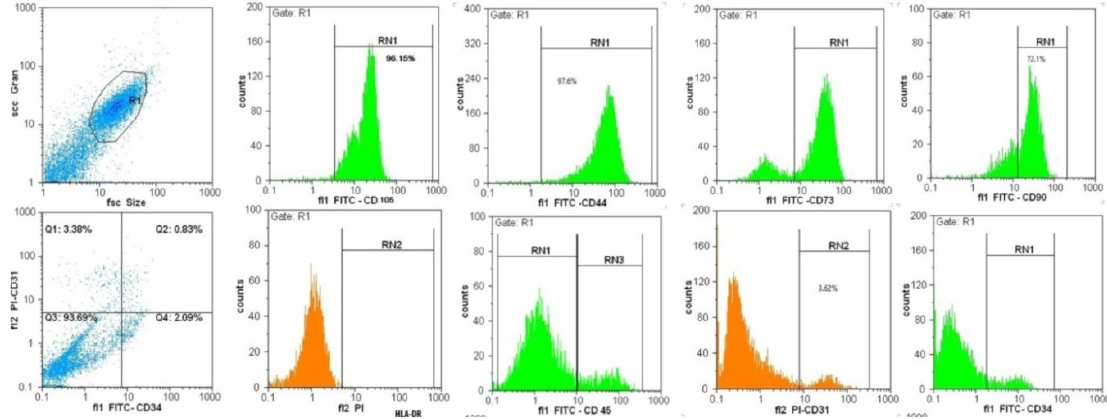
Figure1. Flow cytometry-based immunophenotyping of umbilical cord mesenchymal stem cells derived by MEEM. Cells are prominently positive for CD105, CD44, CD73, and CD90 and negative for HLADR, hematopoietic surface cell markers CD45, CD34, and endothelial cell surface antigen